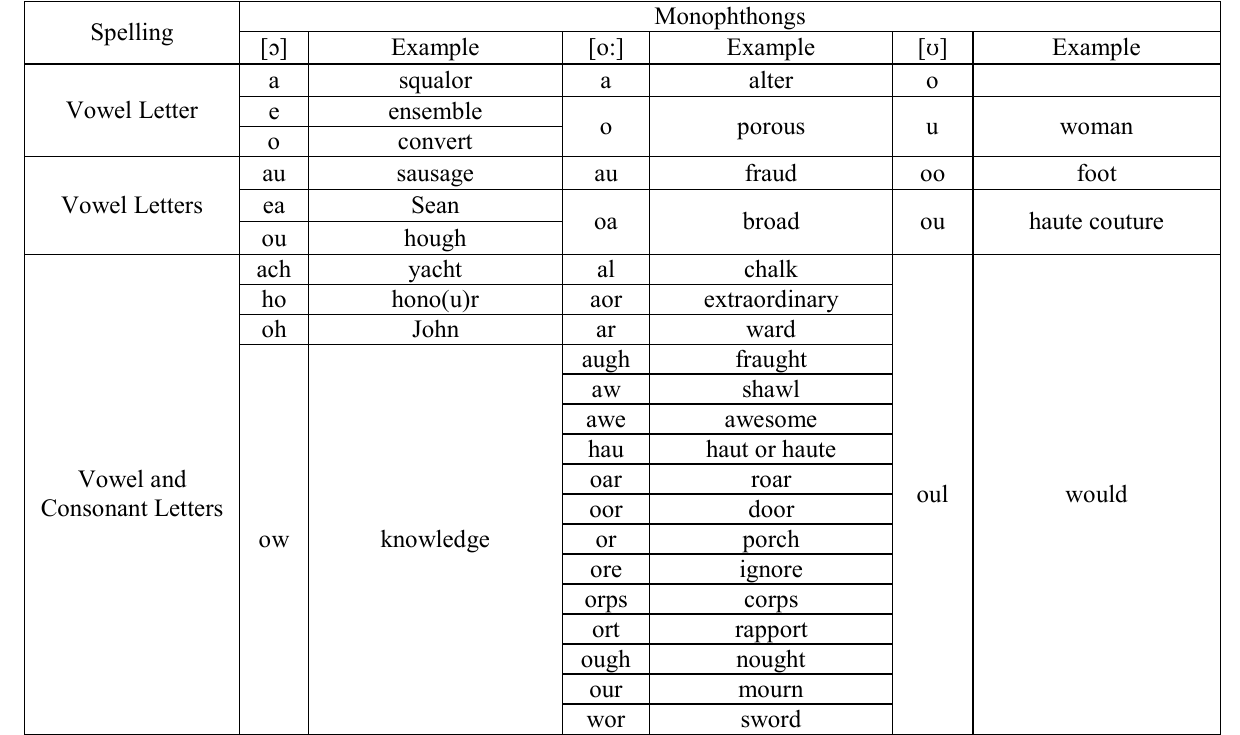
Table 2. Ways of Graphical Spelling of Monophthongs [ ɔ ], [o:] and [ ʊ